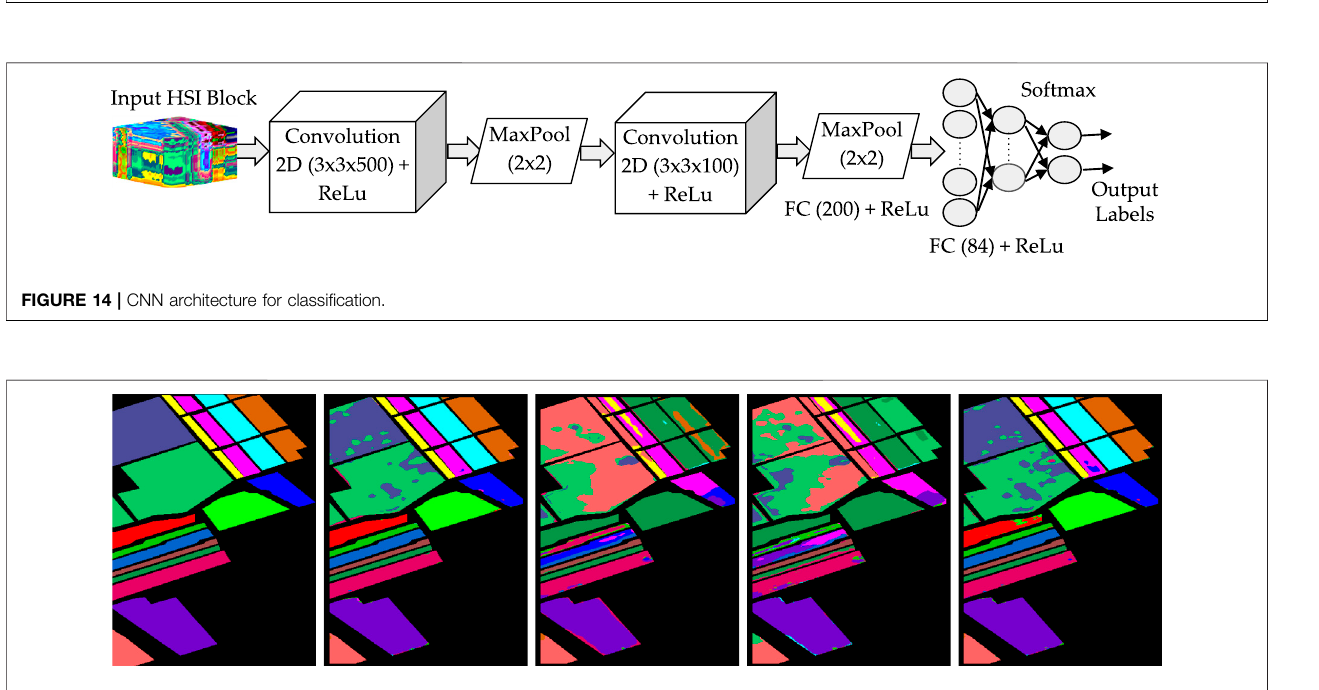
FIGURE 13 | Comparative performance of SSHBCS, RLPHCS, WTL-D, and WTL-I in terms of SAM at different noise levels in CS-based recovery of HSI data: (A) Urban, (B) Jasper Ridge, (C) Salinas. Results are generated at 20 % SR.